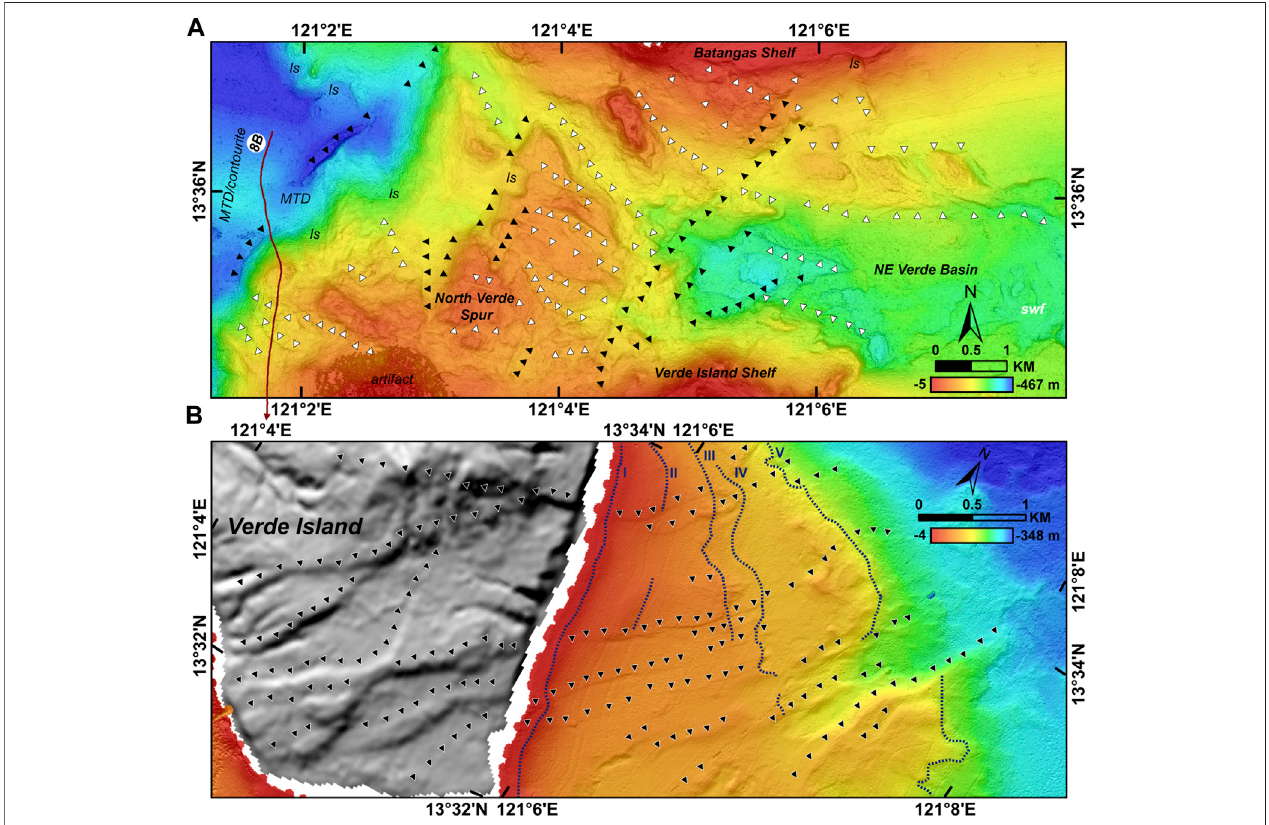
FIGURE 4 | (A) . Closeup of Northern Verde Region. Black arrowheads point to NE-trending lineaments while white arrowheads indicate EW to NW-trending lineaments of the North Verde Fault System. Subbottom pro fi le is in maroon. ls, landslide scarp; MTD, mass transport deposit; swf, sediment wave fi eld. (B) Closeup of the Verde Island Shelf and Verde Island. Black arrowheads point to NE-trending scarps of the Central Verde Fault System. Blue broken lines delineate submarine terraces. Roman numerals indicate each submarine terrace. Please refer to Figure 2 for the location of the fi gures.